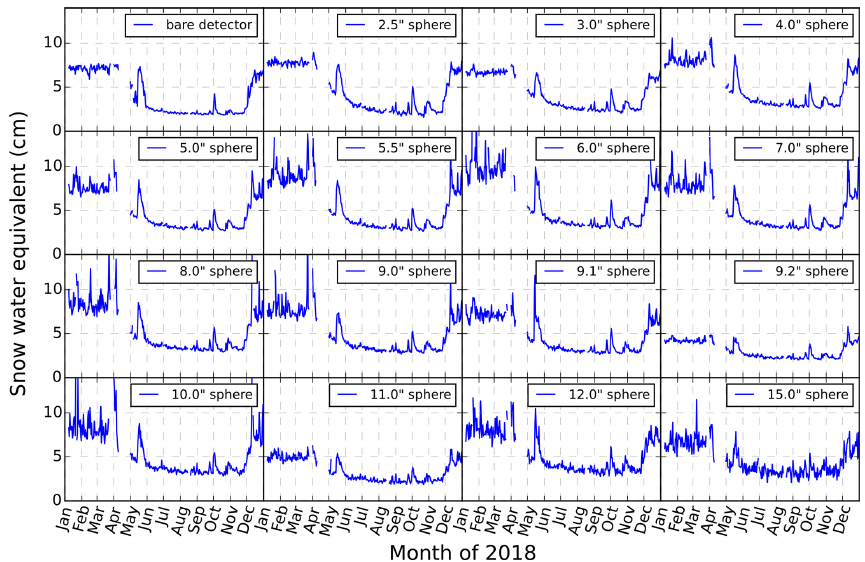
Figure 8. Daily calculated SWE in 2018 based on ERBSS count rates measured at UFS, the exponential fits shown in Fig. 6, and the corre- sponding fit parameters listed in Table 3. Thereby the QGSP_BERT_HP Geant4 physics lists were used to simulate the nuclear